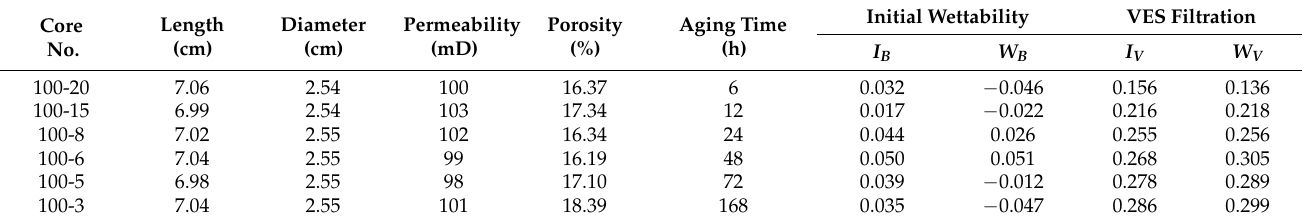
Table 2. Effect of static aging on